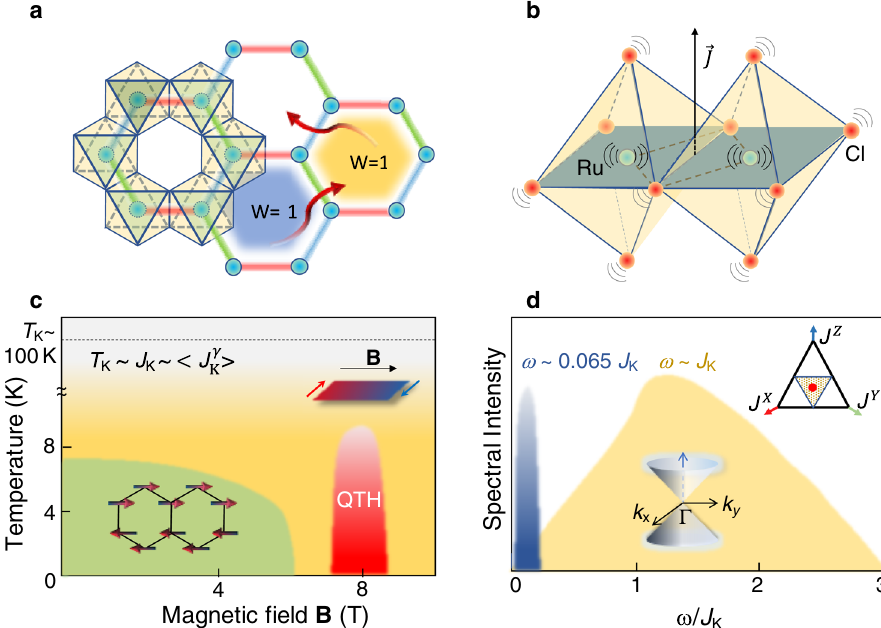
Fig. 1 Schematics of a Kitaev-QSL and the phase diagram of α -RuCl 3 . a Structure motif of α -RuCl 3 based on a honeycomb lattice of edge-sharing Ru – Cl octahedra. The red, green, and blue bonds represent three orthogonal Kitaev interactions J γ K . In the pure Kitaev model [Eq. (1)], the low-energy excitations fractionalize into itinerant MFs (red arrows) and anyonic Z 2 fl ux (blue and yellow hexagons) W = ±1 represents the Z 2 index. b The nearly 90° Ru – Cl – Ru bonds and the moderate spin – orbit-coupling favor an Ising-type magnetic interaction that is perpendicular to the Ru – Cl – Ru plane highlighted in a blue – green color. Lattice vibrations perturbatively modify the magnetic interactions, which induce a coupling between phonons and fractional excitations. c illustrates the phase diagram of α -RuCl 3 on a logarithmic-scale: below T K ~ J K ~8 meV (the yellow area) the thermal Hall conductivity, κ xy , becomes fi nite, indicating a proximate Kitaev-QSL with MF and Z fl ux. In the green area ( T < T = 7 K), non-Kitaev terms drive the system into zigzag 2 gauge N antiferromagnetic order. Under an external magnetic fi eld ( B > 7 T) that completely suppresses the magnetic order, the system is driven into a quantum thermal Hall state at fi nite temperature (the red area). d schematically shows two characteristic Kitaev energy scales in the isotropic limit: the itinerant MF excitation 18 (yellow area) that is broadly peaked around J K and the Z 2 gauge fl ux excitations (blue area) near 0.065 J K